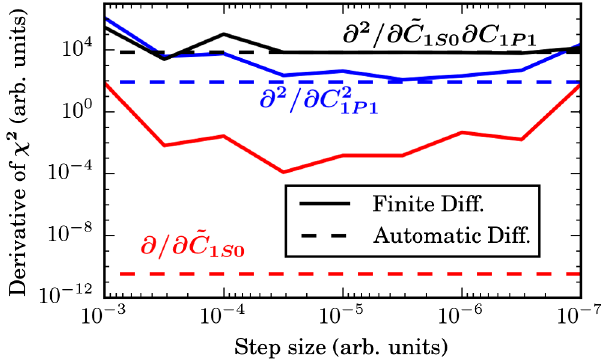
FIG. 4. Comparison between calculated first and second derivatives of an objective function using finite differences (third order) with different step sizes (filled lines) and automatic differentiation (dashed lines). The calculation is done at a minimum where the first derivatives should be approximately zero. Because of cancellation effects, the finite-difference method cannot correctly reproduce the low values of the derivatives for any step